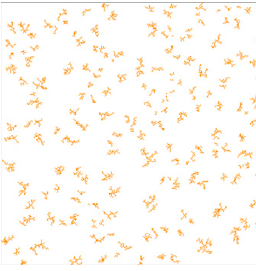
Figure 5. Two-dimensional slice of three-dimensional catalyst porous structure generated by the Figure 5. Two ‐ dimensional slice of three ‐ dimensional catalyst porous structure generated by the MultiDLA model. Structure MultiDLA model. Structure porosity—97%.